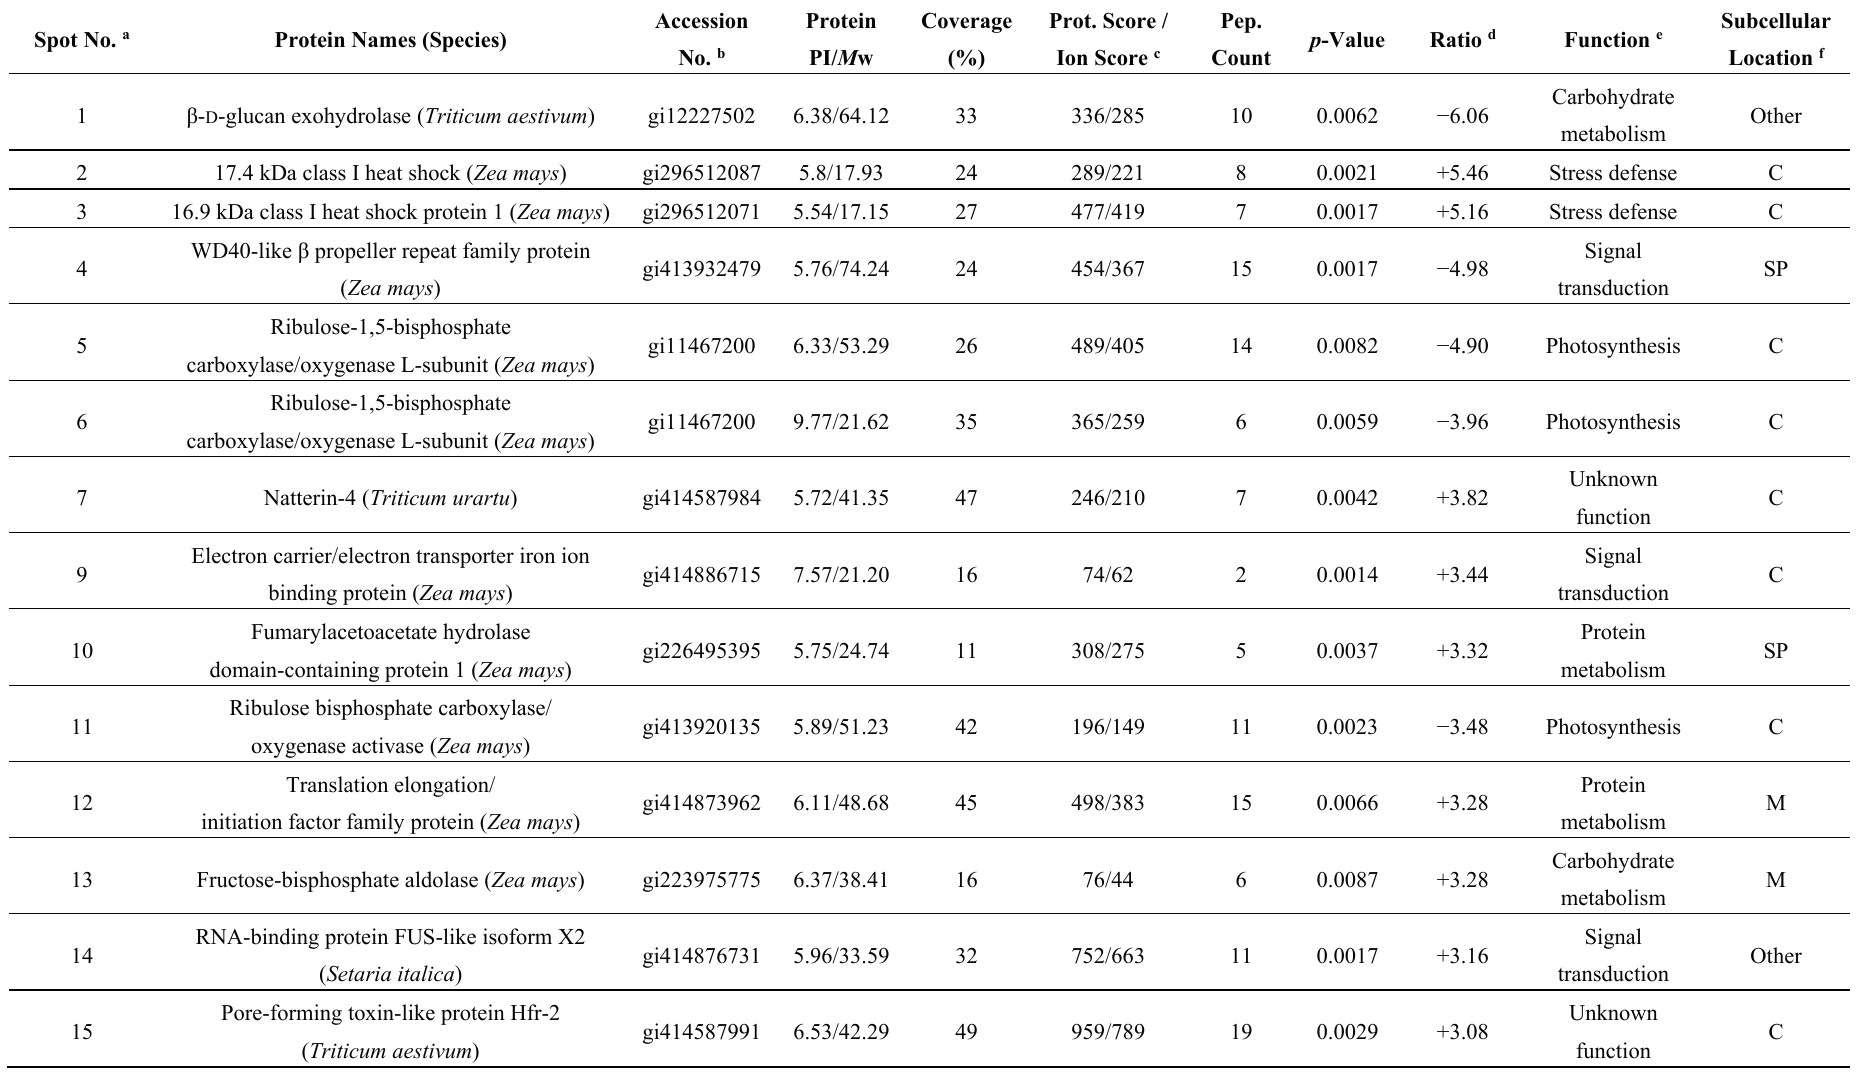
Table 1. Differentially expressed protein species in leaves of maize seedlings exposed to 20% PEG-stimulated water deficiency for two days. Spot No.